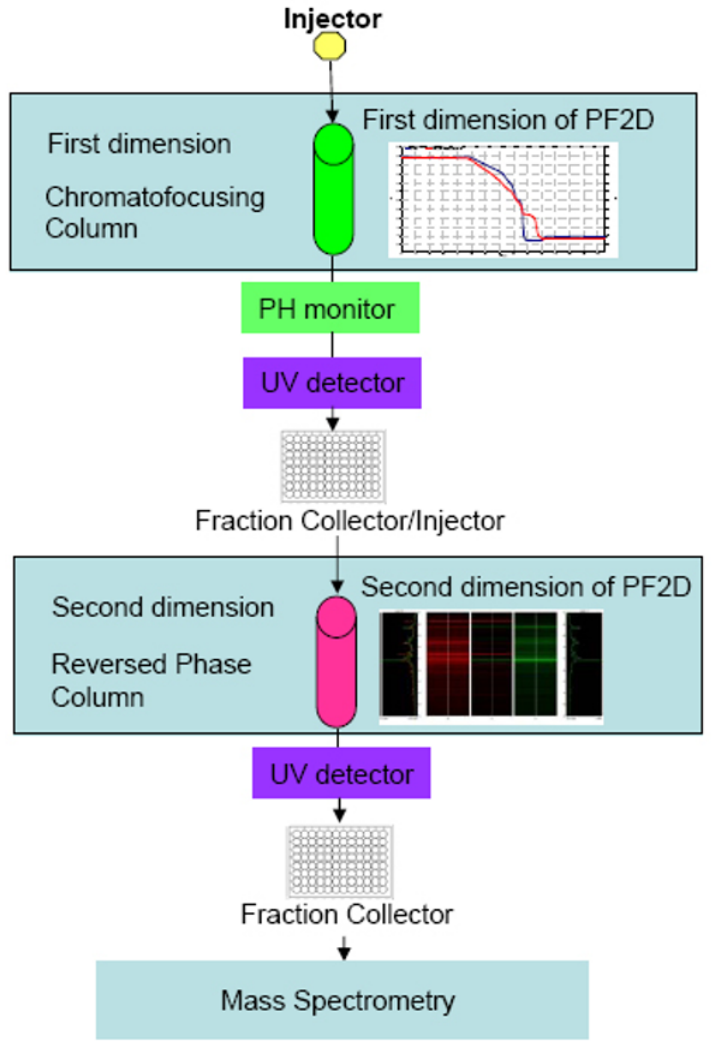
Figure 1. Two-dimensional LC (2D-LC) from Beckman Coulter, the Proteome-LabTM PF2D platform (PF2D).